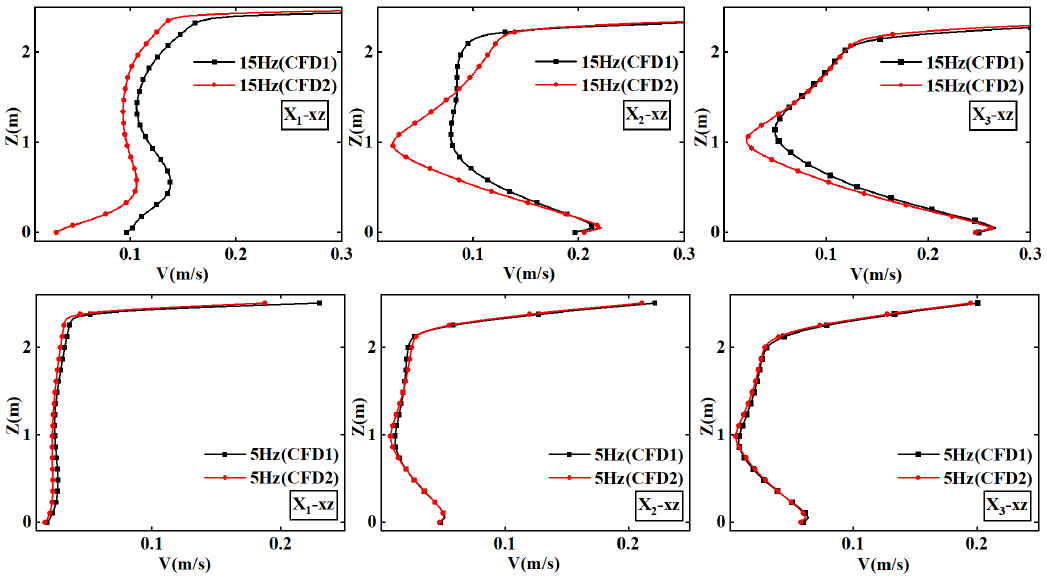
Figure 13. Calculated velocity profiles for RGD at three positions.